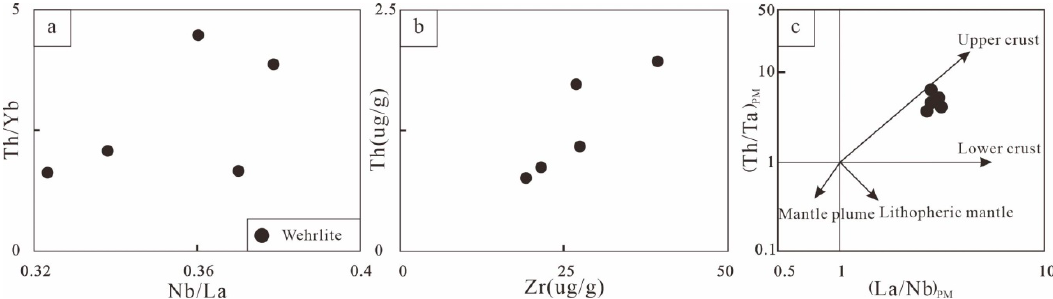
Figure 7. Plots of selected trace elements for evaluating contamination processes of the Gayahedonggou wehrlite. Figure 7c is modified from [51]. ( a ) Nb/La-Th/Yb; ( b ) Zr/Th; ( c ) (La/Nb) PM -(Th/Ta) PM diagrams for the Gayahedonggou wehrlite.